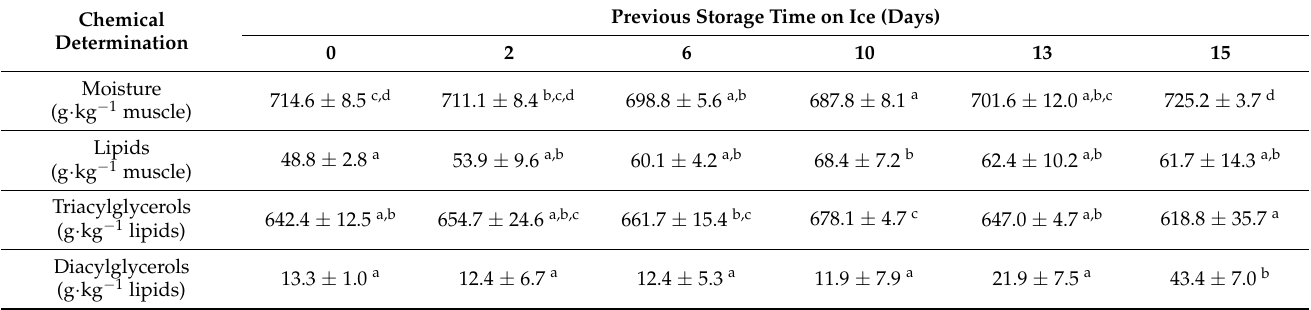
Table 1. Chemical analysis of canned sardines subjected to storage on ice before canning. Previous Storage Time on Ice (Days) Chemical Determination 0 2 6